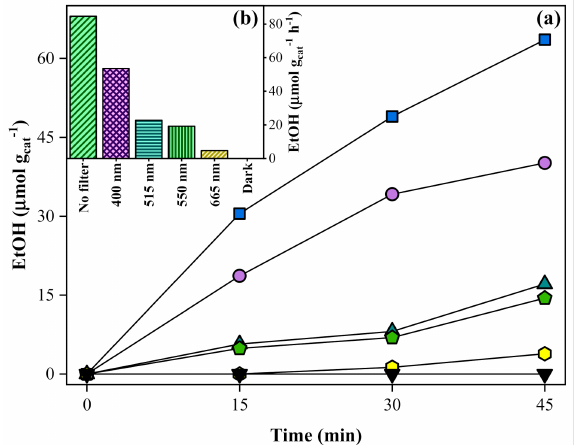
Figure 8. Evolution of the ( a ) ethanol production from CO 2 and C 2 H 6 over time and the respective ( b ) reaction rate (for the maximum production), as a measure of the catalyst photoresponse under full illumination (1000 W m − 2 ), using filters with different cut-offs: no filter ( ), 400 nm ( ), 515 nm ( ), 550 nm ( ), 665 nm ( ), and dark ( , covering the photoreactor with aluminum foil). Experimental conditions: 20 mg of SrTiO 3 :RuO 2 :NiO; [Ru]:[Ni] = 1:1 (molar); Ru = 0.8 wt. %; P C = 0.35 bar; and T = 200 ◦